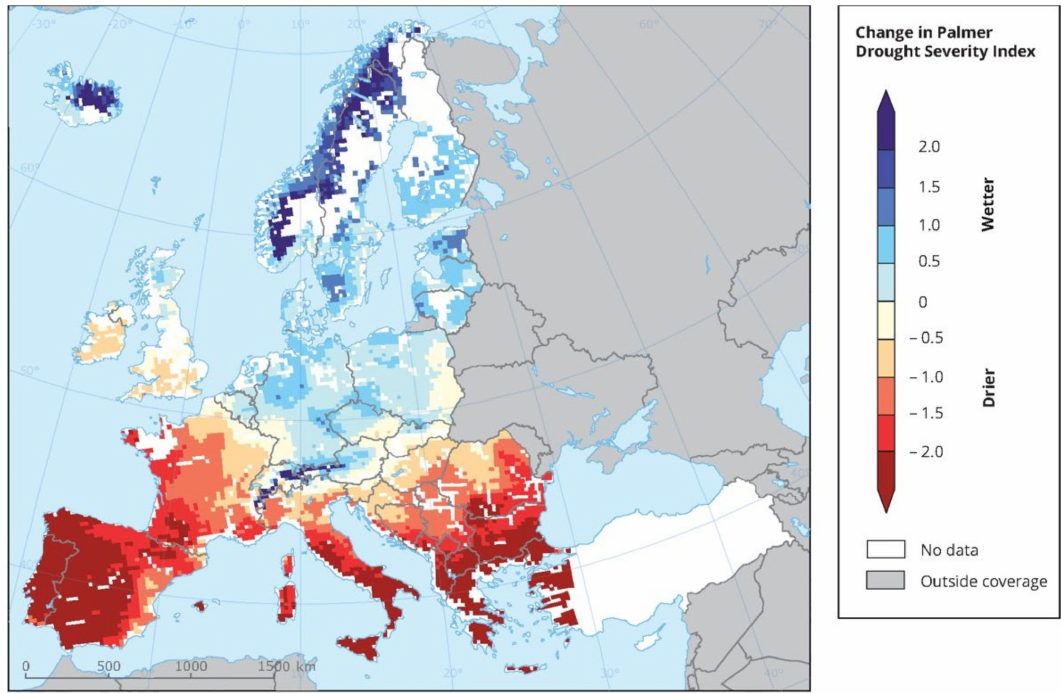
Figure 1. Projected PDSI change between 1961–1990 and 2021–2050 using 12 regional climate mod- els (RCMs). Red and blue, respectively, indicate drier and wetter conditions. Source: European Environmental Agency, Indicator assessment (2017). https://www.eea.europa.eu/data-and-maps/ indicators/water-retention-4/assessment (accessed on 30 January